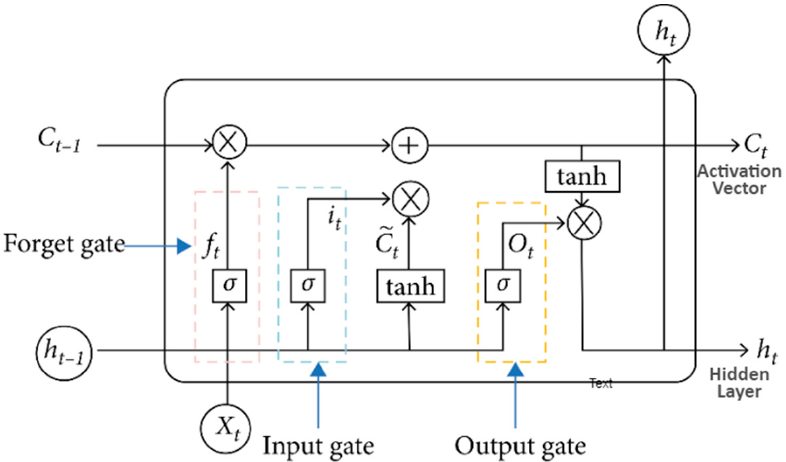
Figure 2. Architecture of LSTM.